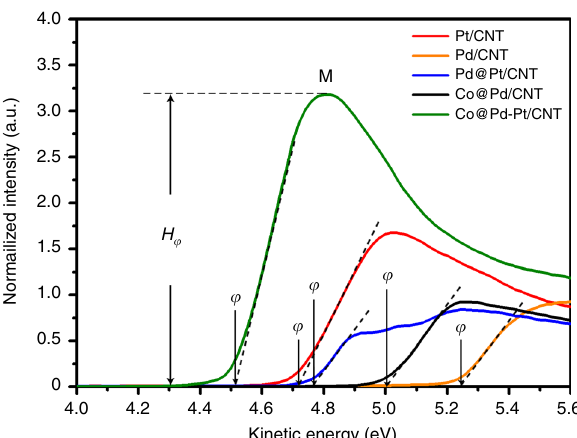
Fig. 3 Ultraviolet photoelectron spectra of Pt-decorated Co-Pd and controls. The work function of Pt-decorated Co-Pd (Co@Pd-Pt/carbon nanotube (CNT)) catalyst is lower than that of the control samples including Pt/CNT, Pd/CNT, Pd-Pt core-shell (Pd@Pt/CNT), and Co-Pd core-shell